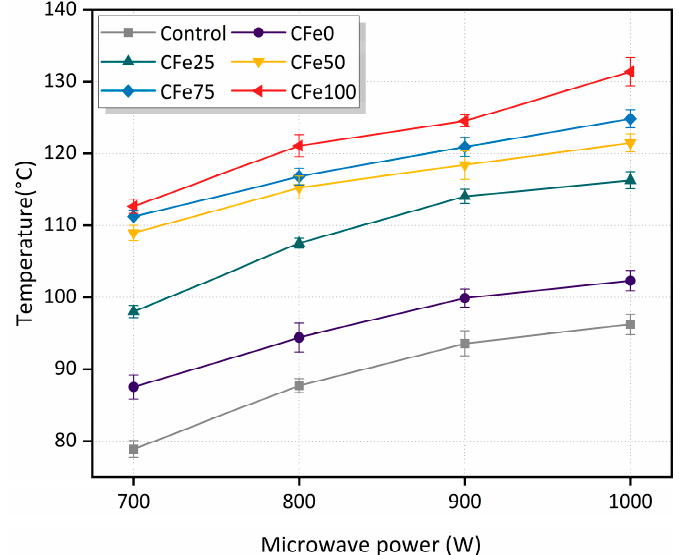
Figure 12. Change in the surface temperature of the specimens with microwave power at 8 min.